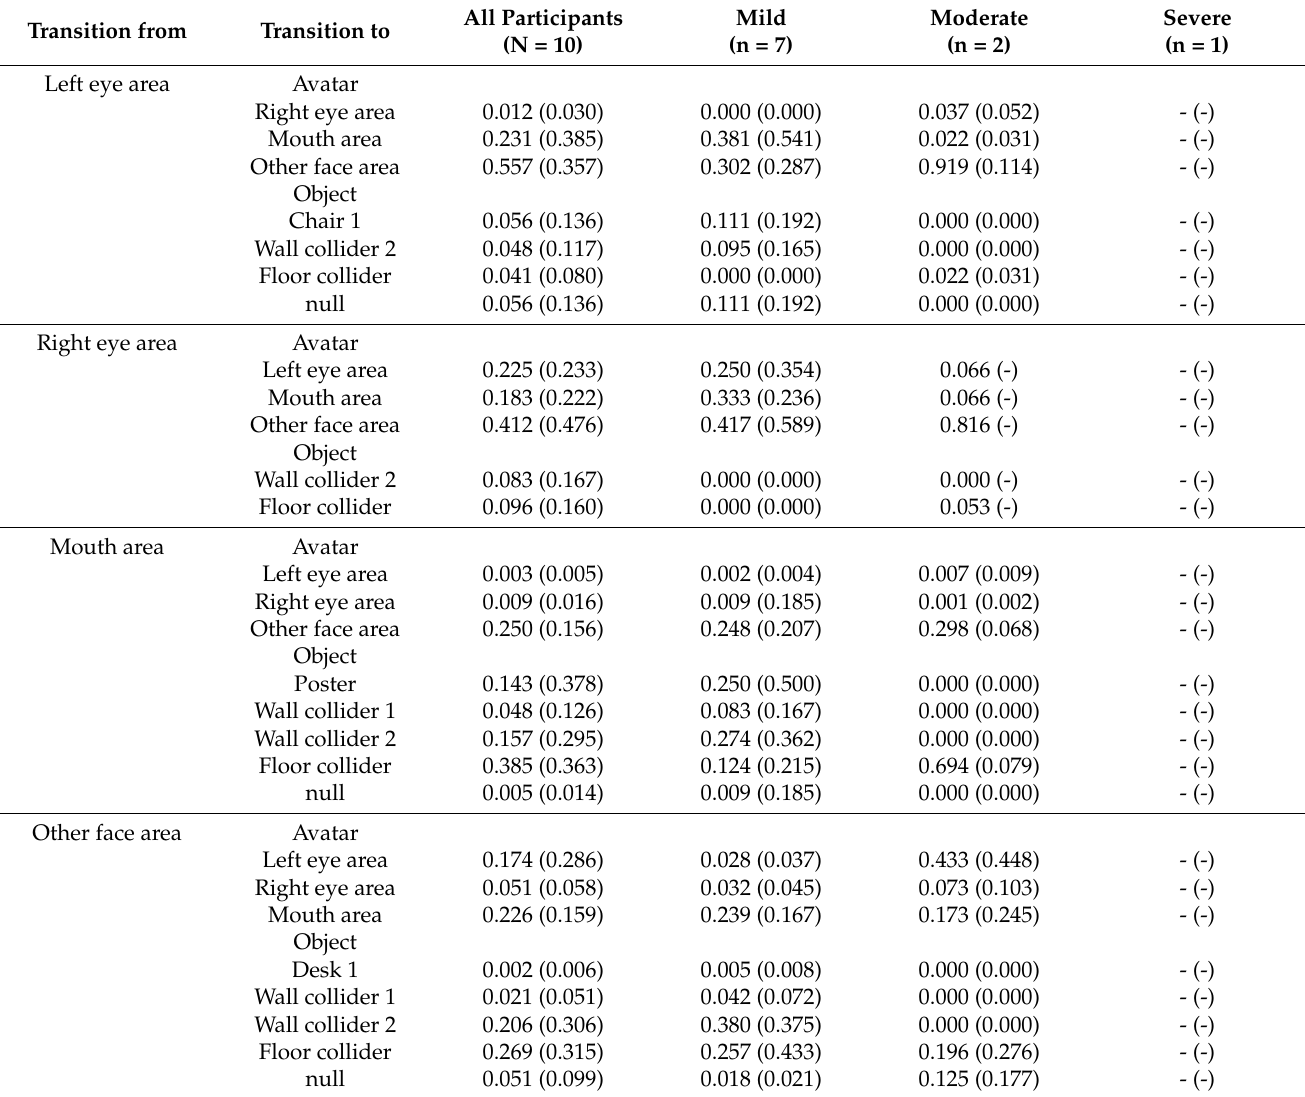
Table 3. Gaze transition probability from the face of avatar, mean